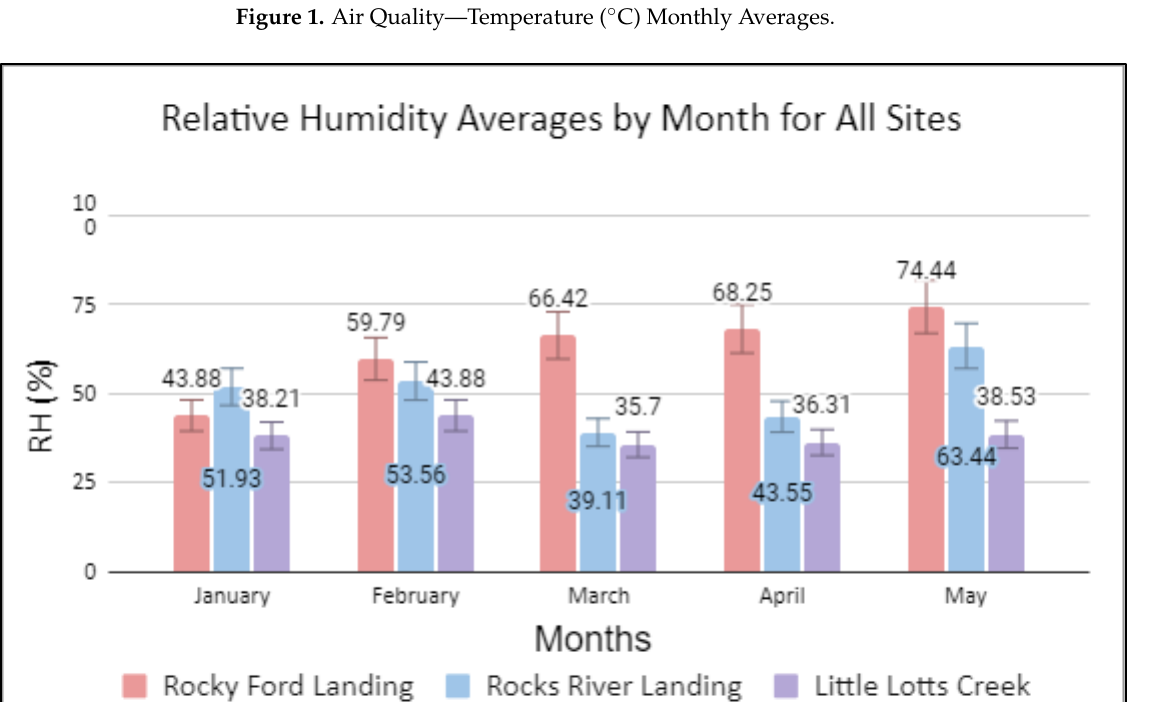
Figure 1. Air Quality — Temperature (°C) Monthly Averages.